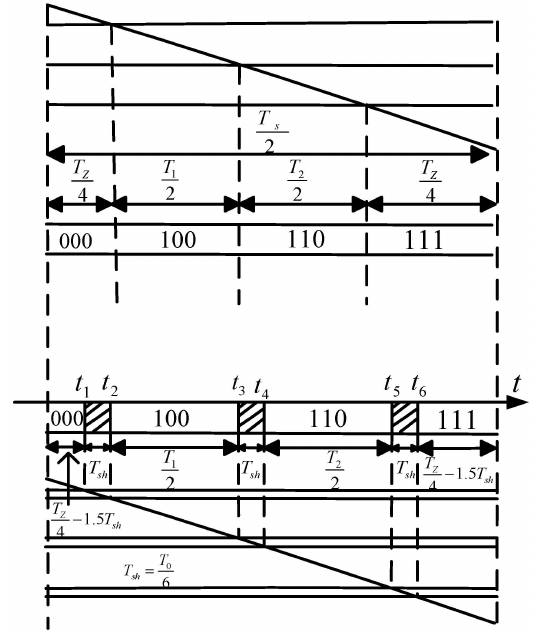
Figure 4. Diagram of traditional pulse-width modulation (PWM) scheme for